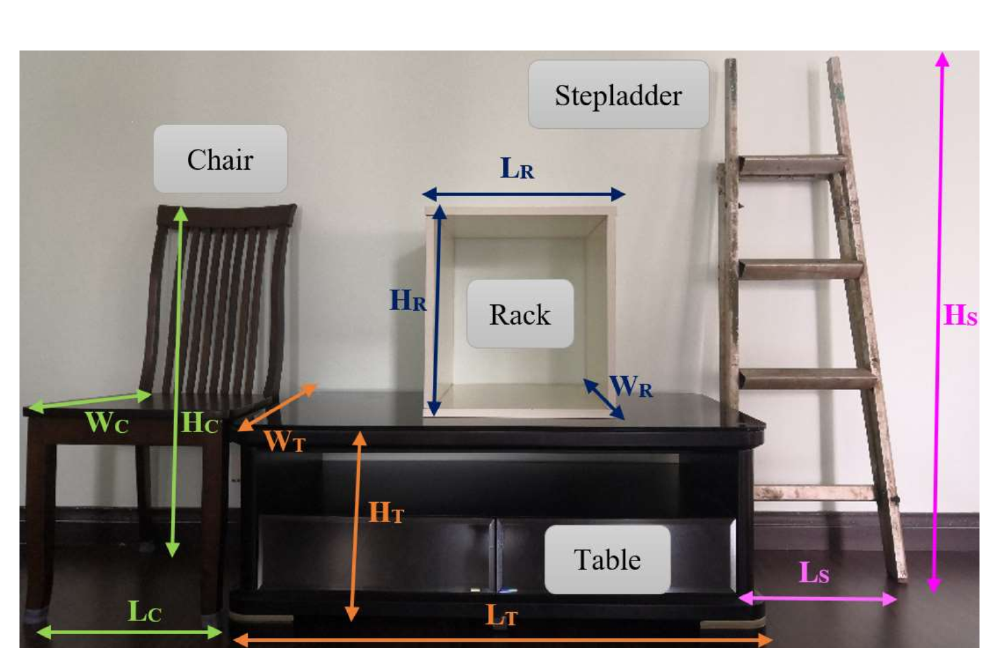
Figure 18. Dimension measurement of single-function furniture. Notes: L C —Length of chair; W C — Width of chair; H C —Height of chair; L T —Length of table; W T —Width of table; H T —Height of table; L R —Length of rack; W R —Width of rack; H R —Height of rack; L S —Length of stepladder; H S —Height of